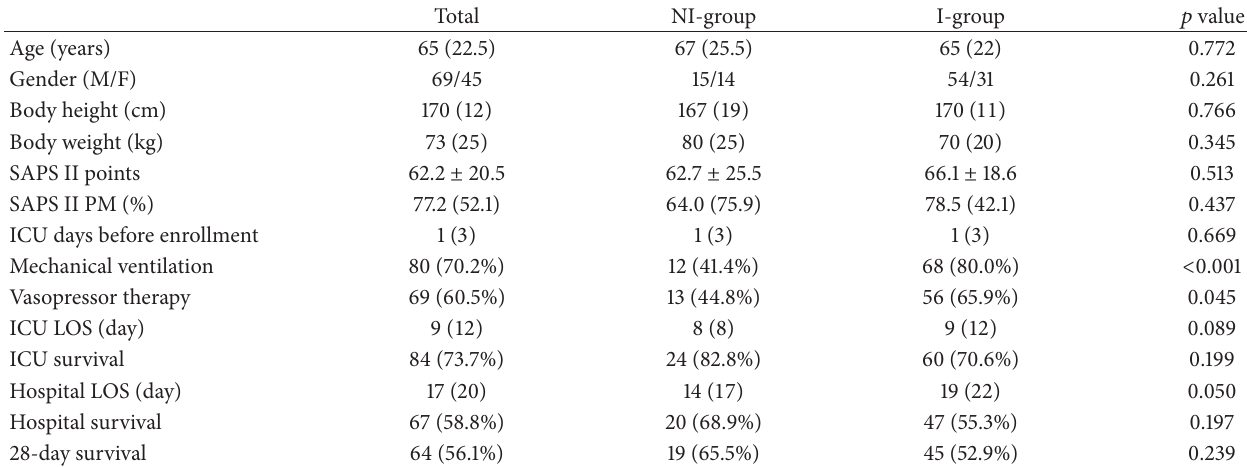
Table 1: Demographics, organ support, and outcome in the entire cohort.